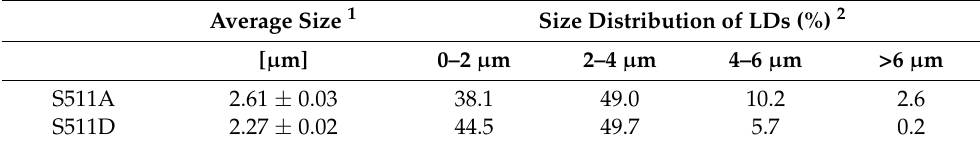
Table 3. Size distribution of LDs overexpressing perilipin 1